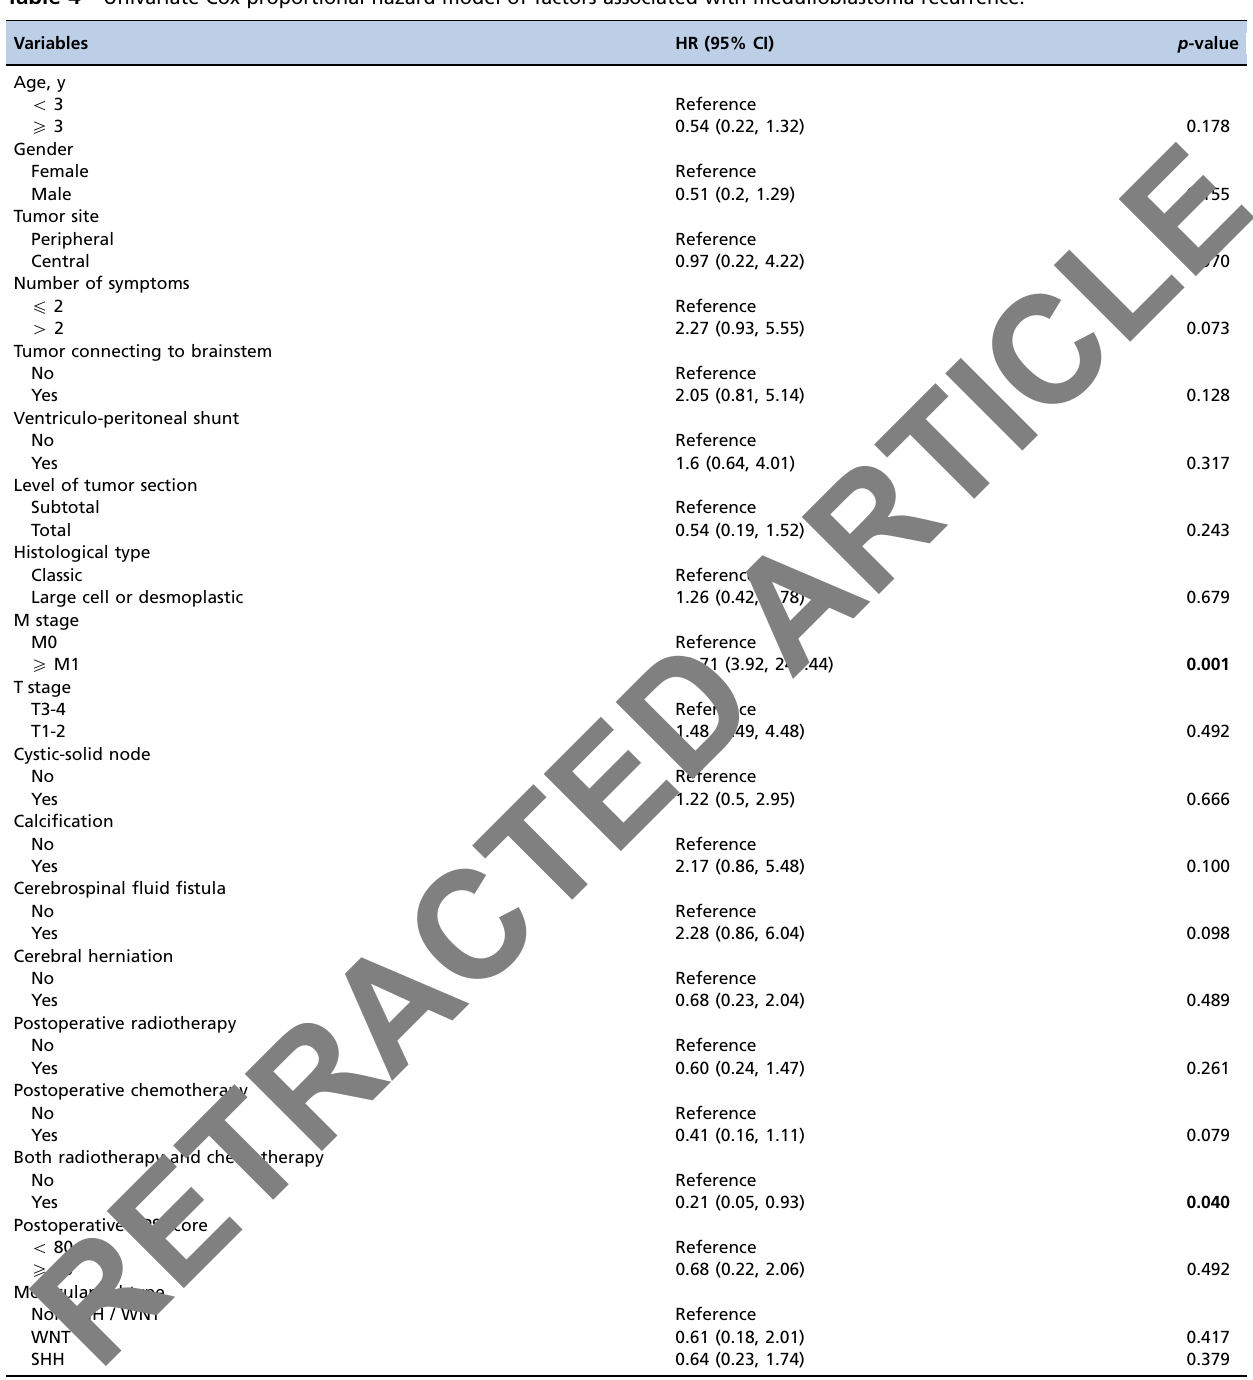
Bold values indicate statistical significance, p o